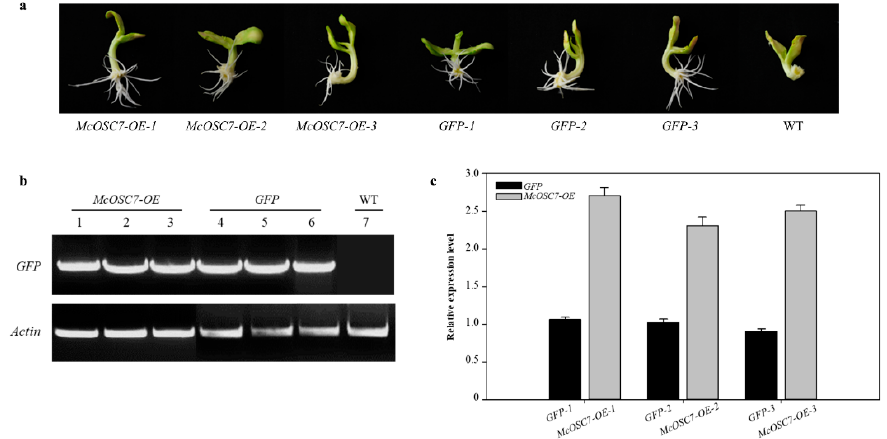
Figure 3. Identification of bitter gourd hairy roots and gene transcript level analysis. ( a ) Pictures of McOSC7 overexpression ( McOSC7 - OE ), GFP empty, and uninfected bitter gourd (WT) roots; ( b ) Results of PCR analyses of Actin in McOSC7 ‐ OE , GFP empty, and WT roots; ( c ) Relative gene transcript levels in GFP and McOSC7 ‐ OE transgenic materials.